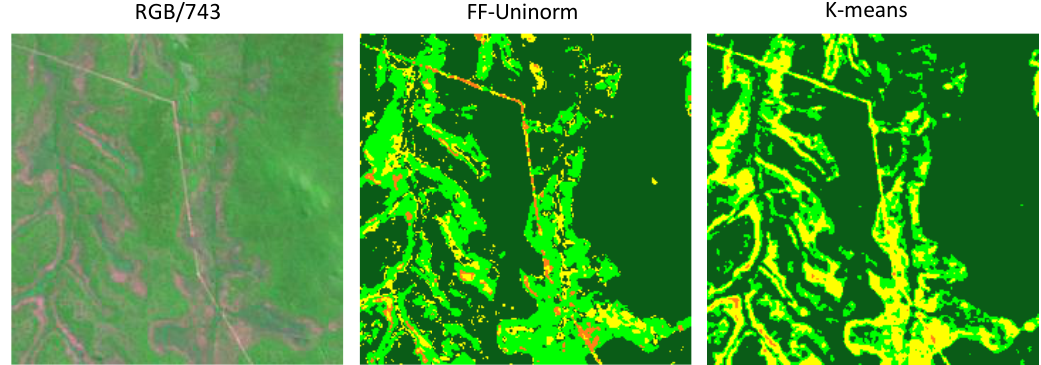
Figure 6. Detail of the land cover classification using FF-Uninorm and k-means, where a road is clearly seen and correctly identified by both methods.